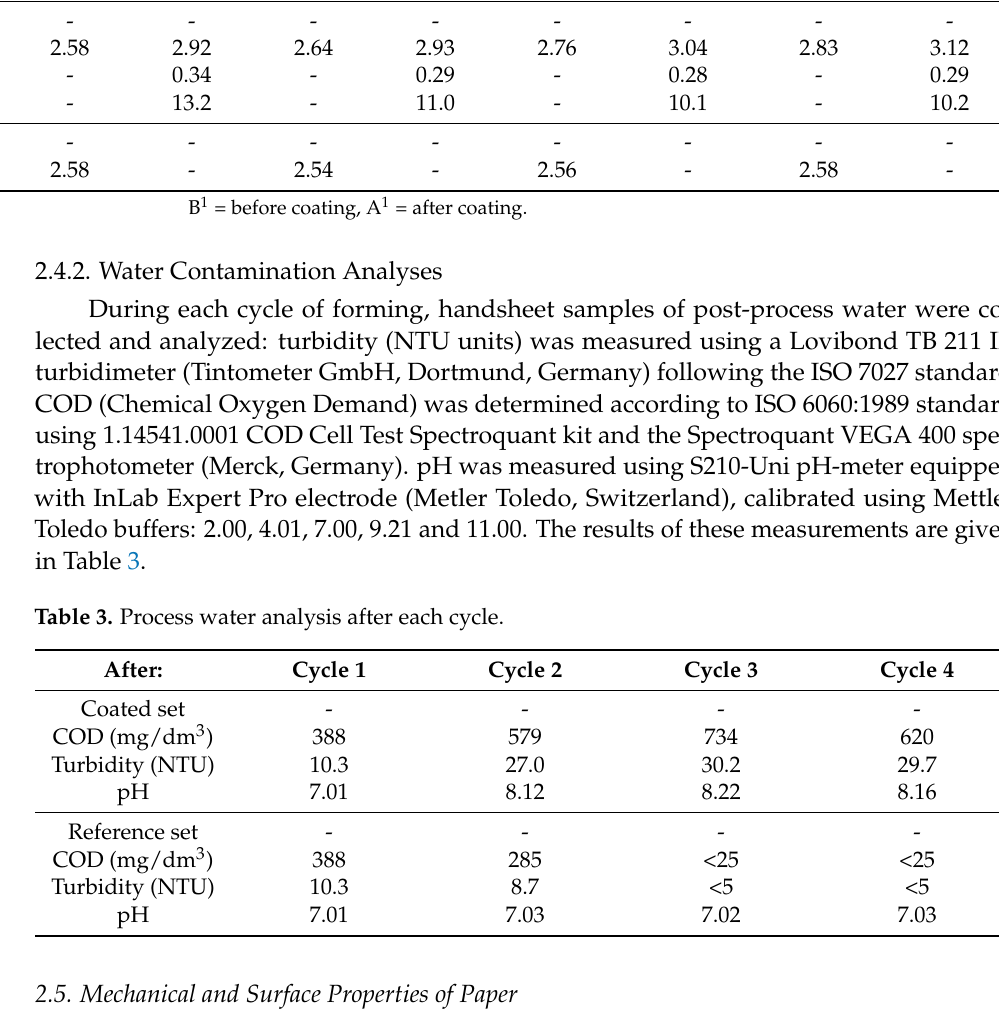
Table 2. Arithmetic average weights of handsheets after each cycle of disintegrating, forming, and coating. Description